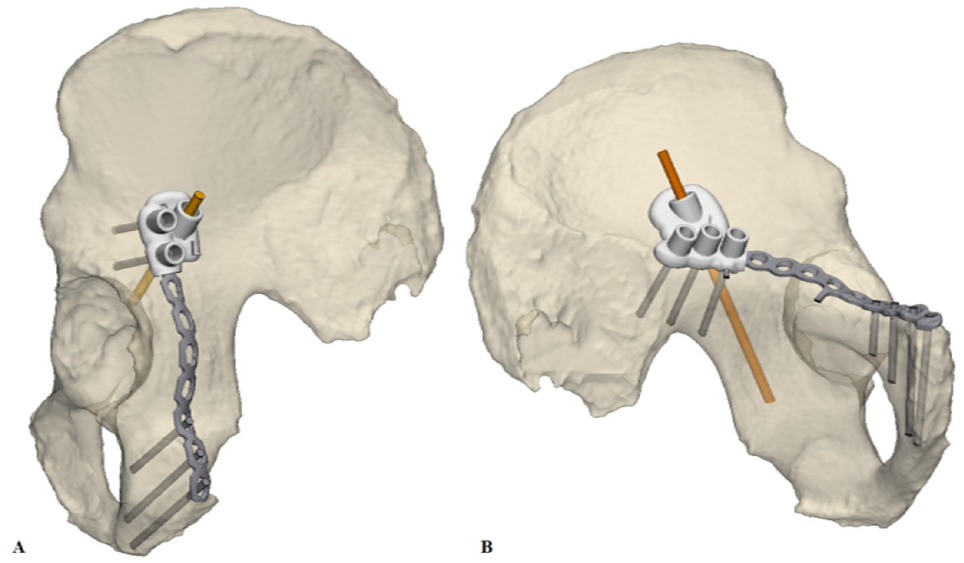
Figure 2. Drilling guides. Separate drilling guides were designed for the anterior and posterior column screws. ( A ): The drilling guide for the retrograde anterior column screw, ( B ): The drilling guide for the posterior column screw.